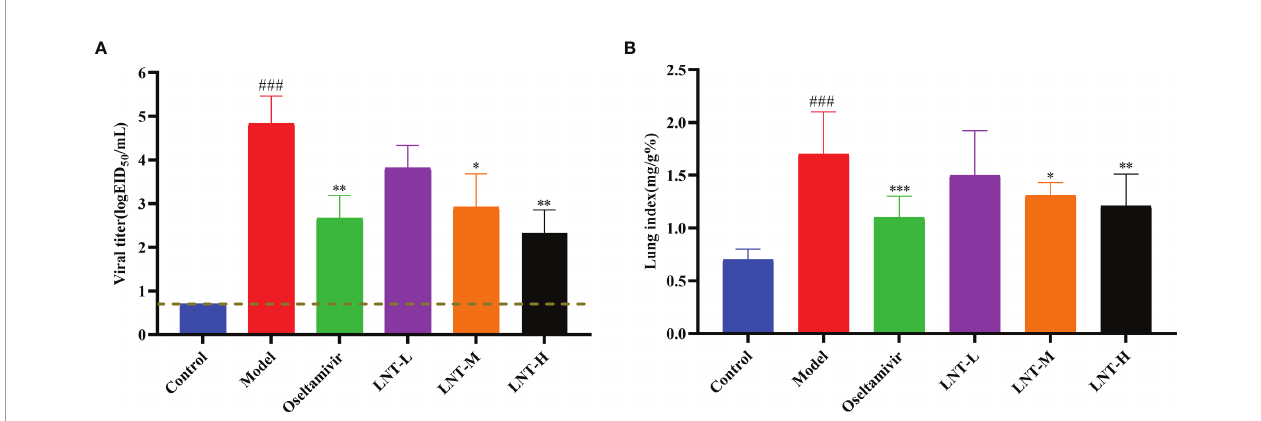
FIGURE 2 | Protective effect of LNT on the lungs of mice infected with in fl uenza virus. Male ICR mice were intranasally infected with 2 LD 50 in fl uenza virus A/PR/8/ 34 (H1N1). At 5 dpi, the lungs were harvested from the euthanized mice and weighed to calculate the lung index (B) . At the same time, the virus titer in the lungs was titrated with SPF chicken embryos (A) . ### p < 0.001, vs. control group (n=10); *p < 0.05, **p < 0.01, ***p < 0.001, vs. model group (n=10).